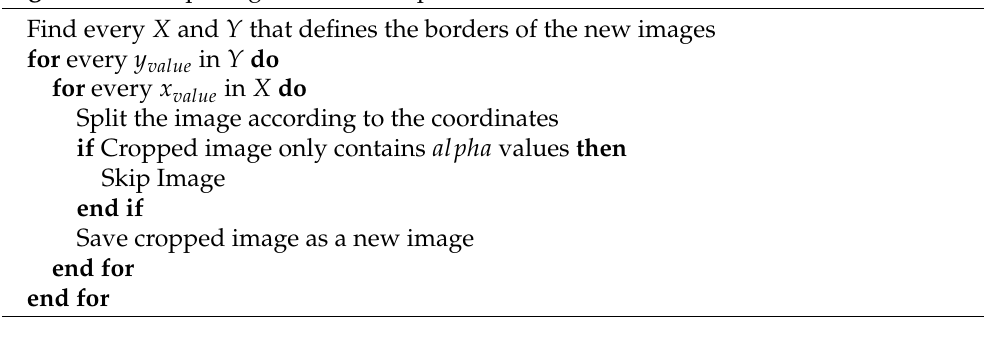
Algorithm 2 Separate images into train batch and test